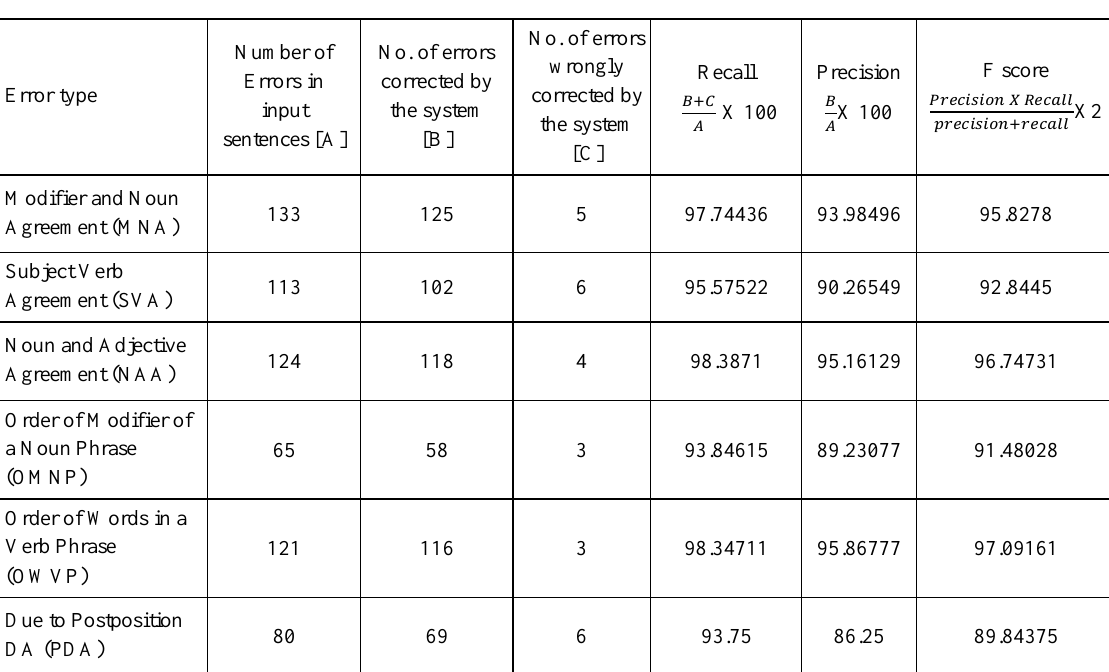
Table 3.3: Experimental evaluation of grammar checking of compound sentences (Hindi to Punjabi Machine translation